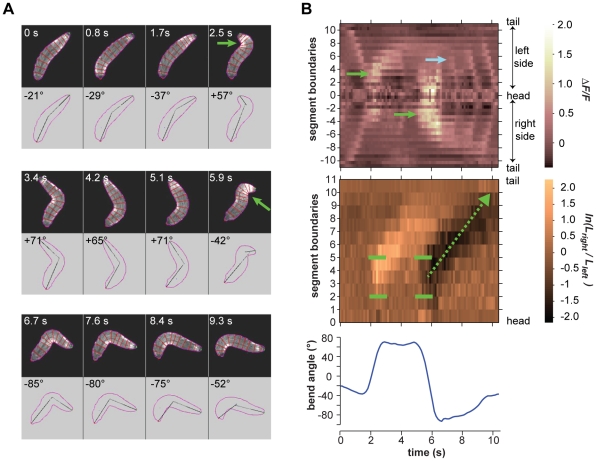
Turning decisions with multiple head sweeps.
A. Video frames of a turning decision during cooling in which two head sweeps were executed in rapid succession. Upper panel in each video frame shows fluorescence image. Outline and boundaries between segments are shown in red. Lower panel in each video frame shows the perimeter, centerline, and body bend angle as analyzed by machine vision software. Green arrows show the asymmetric bends that are flagged as head sweeps. B.
(Upper panel) Kymograph of fluorescence intensity within body segments for the video segment shown in A. Green arrows show the greater increase in fluorescence intensity, first on the left side then the right side of the animal, signifying the leftward and rightward head sweeps. Blue arrow shows the increase in fluorescence intensity in the A3 segment, signifying the resumption of peristalsis near the bend.(Middle panel) Kymograph of the logarithm of the ratio between the lengths of segment boundaries on the left side and right side of the animal. Green brackets indicate the margins of the region of asymmetric contraction, positive values signifying the leftward bend and negative values signifying the rightward bend. One peristalsis wave occurs after the leftward head sweep. Green arrow shows the retrograde progression of the region of asymmetric contraction that straighten the body during three peristalsis waves after the rightward head sweep. (Lower panel) Time course of body bend angle, operationally defined to flag reorientation maneuvers as described in Materials and Methods, shows the initial rise that signifies the leftward head sweep and drop that signifies the subsequent rightward head sweep.